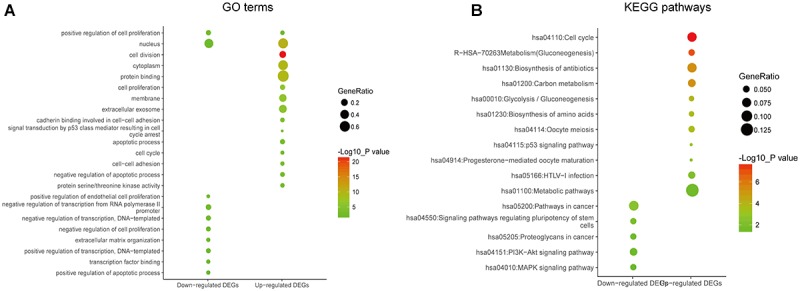
Gene ontology and pathway enrichment analyses of the common DEGs. (A) GO enrichment analysis of the common DEGs. The y-axis labels represent clustered GO terms. The GeneRatio represents the ratio of the number of genes enriched in one GO term to the number of upregulated or downregulated DEGs. (B) KEGG enrichment analysis of the common DEGs. The y-axis labels represent clustered KEGG pathways. The GeneRatio represents the ratio of the number of genes enriched in one KEGG pathway to the number of upregulated or downregulated DEGs. GO, gene ontology; DEGs, differentially expressed genes; KEGG, Kyoto Encyclopedia of Genes and Genomes.